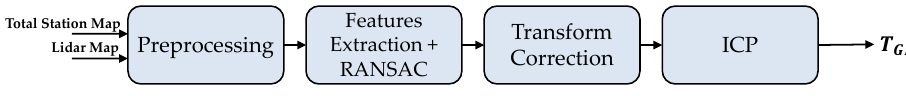
Figure 7. Global localization